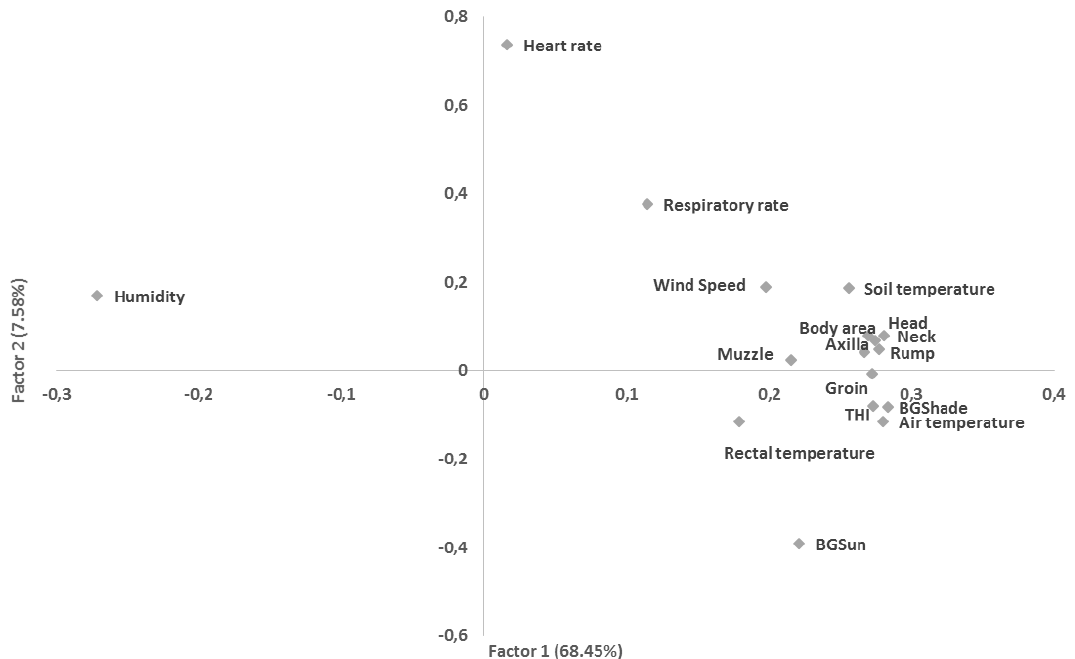
Figure 1. Principal factor analysis for surface temperatures, physiological and environmental parameters analyzed. BGSun: black globe temperature in the sun; BGSha: black globe temperature in the shadow; body area, head, neck, axilla, rump, muzzle and groin surface temperatures; THI: temperature and humidity index.